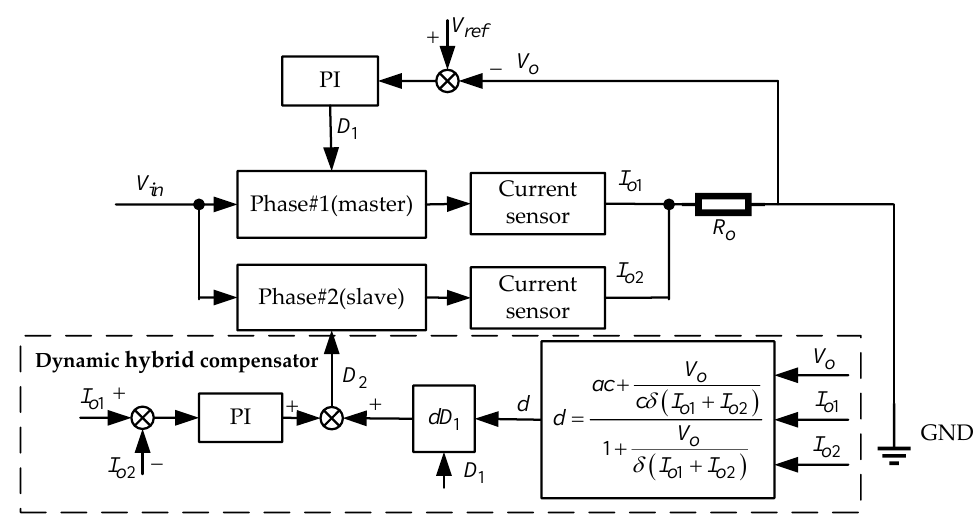
Figure 11. Block diagram of parallel PSFB with DHC.